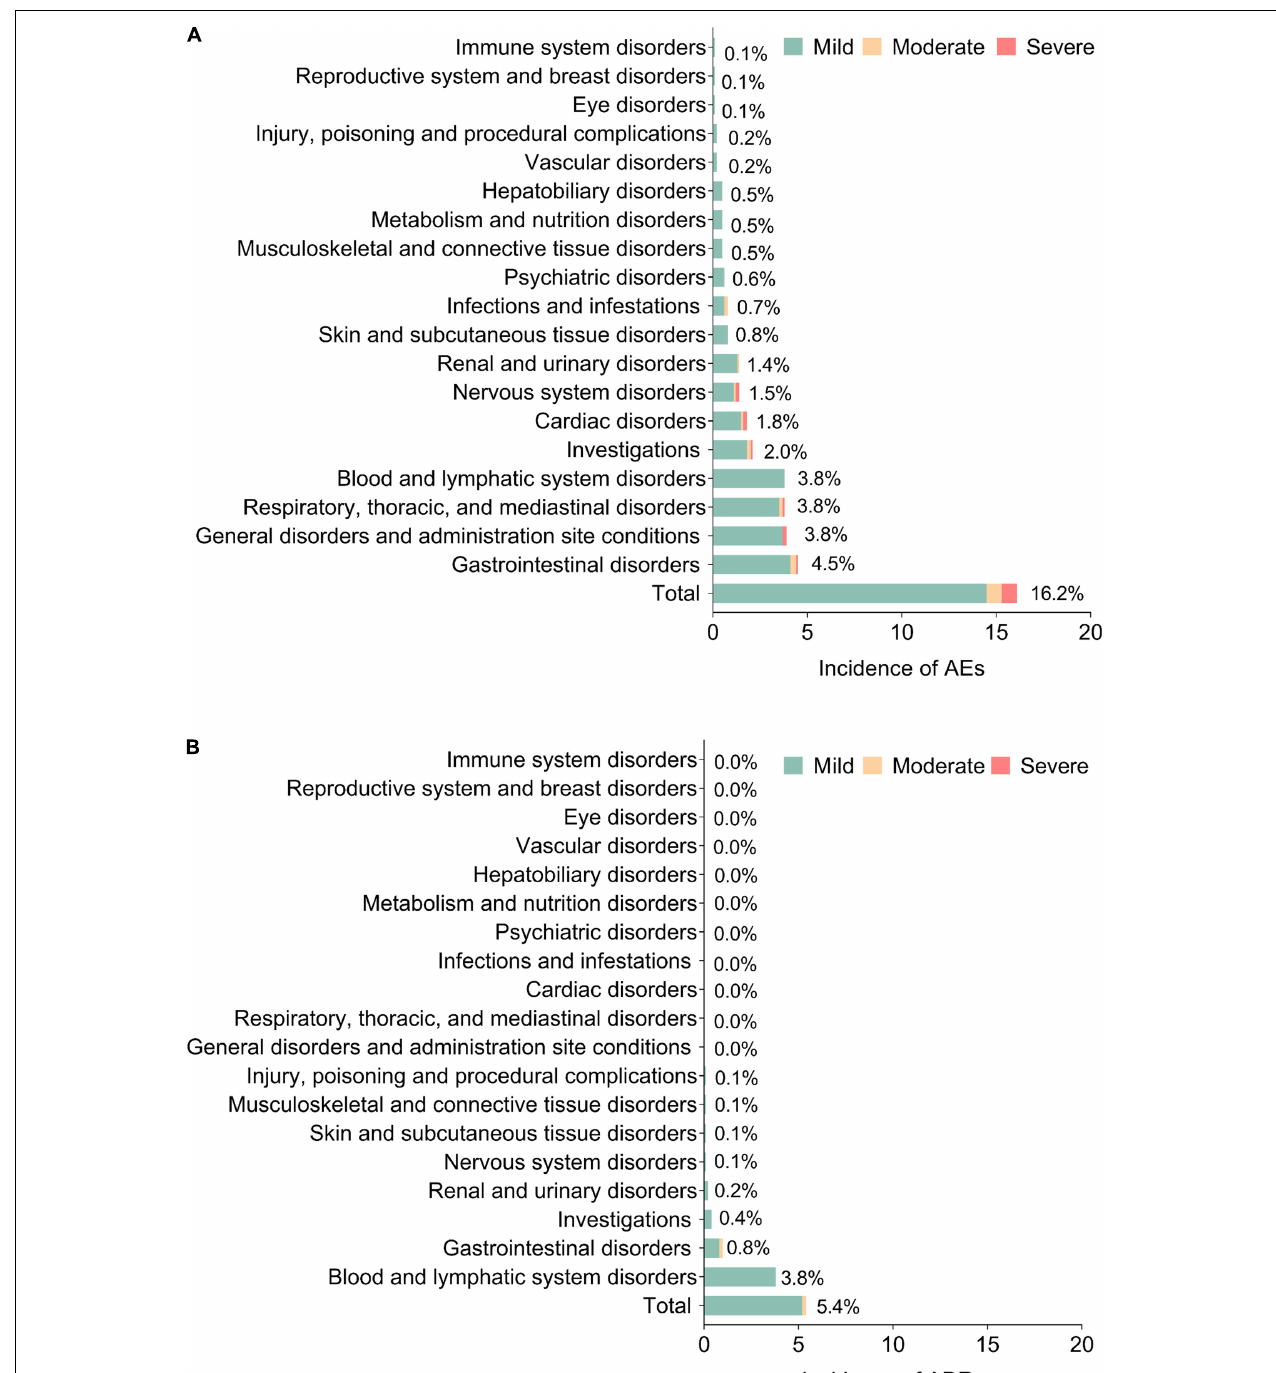
FIGURE 2 | Detailed AEs and ADRs. Incidence of AEs (A) and ADRs (B) in system organ class (SOC). AEs, adverse events; ADRs, adverse drug reactions.